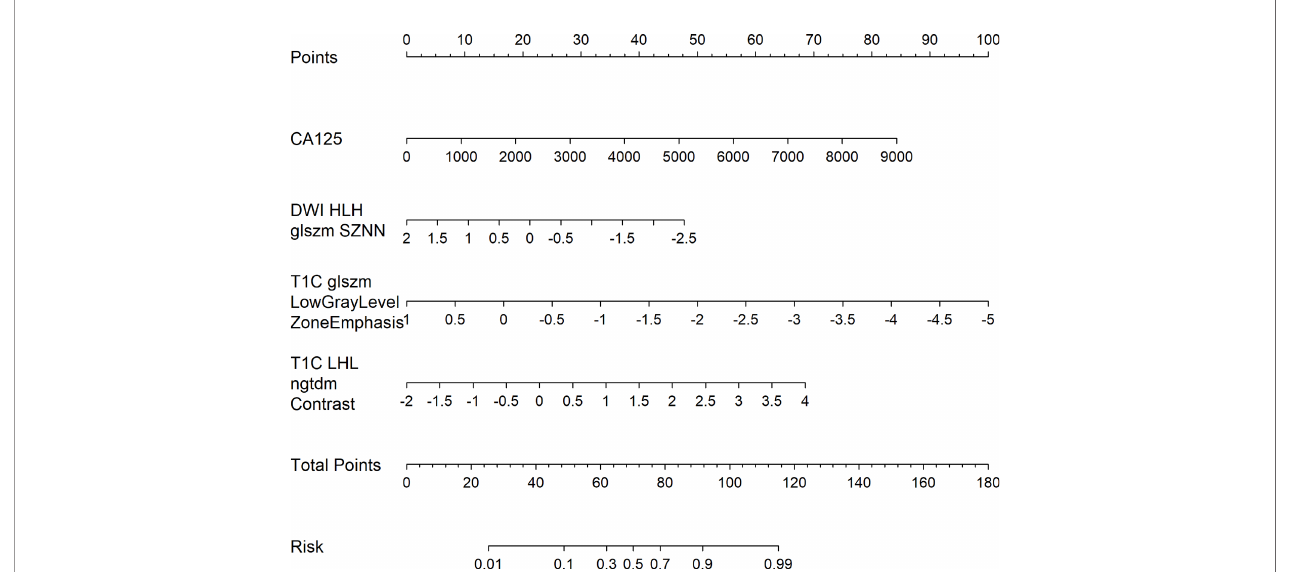
FIGURE 5 | Radiology nomogram. The radiology nomogram prediction model predicts the probability of PC in patients with epithelial ovarian cancer. The model is developed in a training group with radiomic characteristics and one clinical feature. How to use: (1) locate the patient ’ s CA125 and then draw a straight line on the top dot axis to obtain a score related to CA125; (2) the patient ’ s radiologic score is found on the characteristic axis of Radiology, and a line is drawn vertically up along the “ point ” axis. The process is repeated for each variable. (3) Sum up the sum of the four major risk factors. (4) Find the fi nal sum on the Total Point axis and draw a straight line down to assess PC ’ s risk in patients with epithelial ovarian cancer.